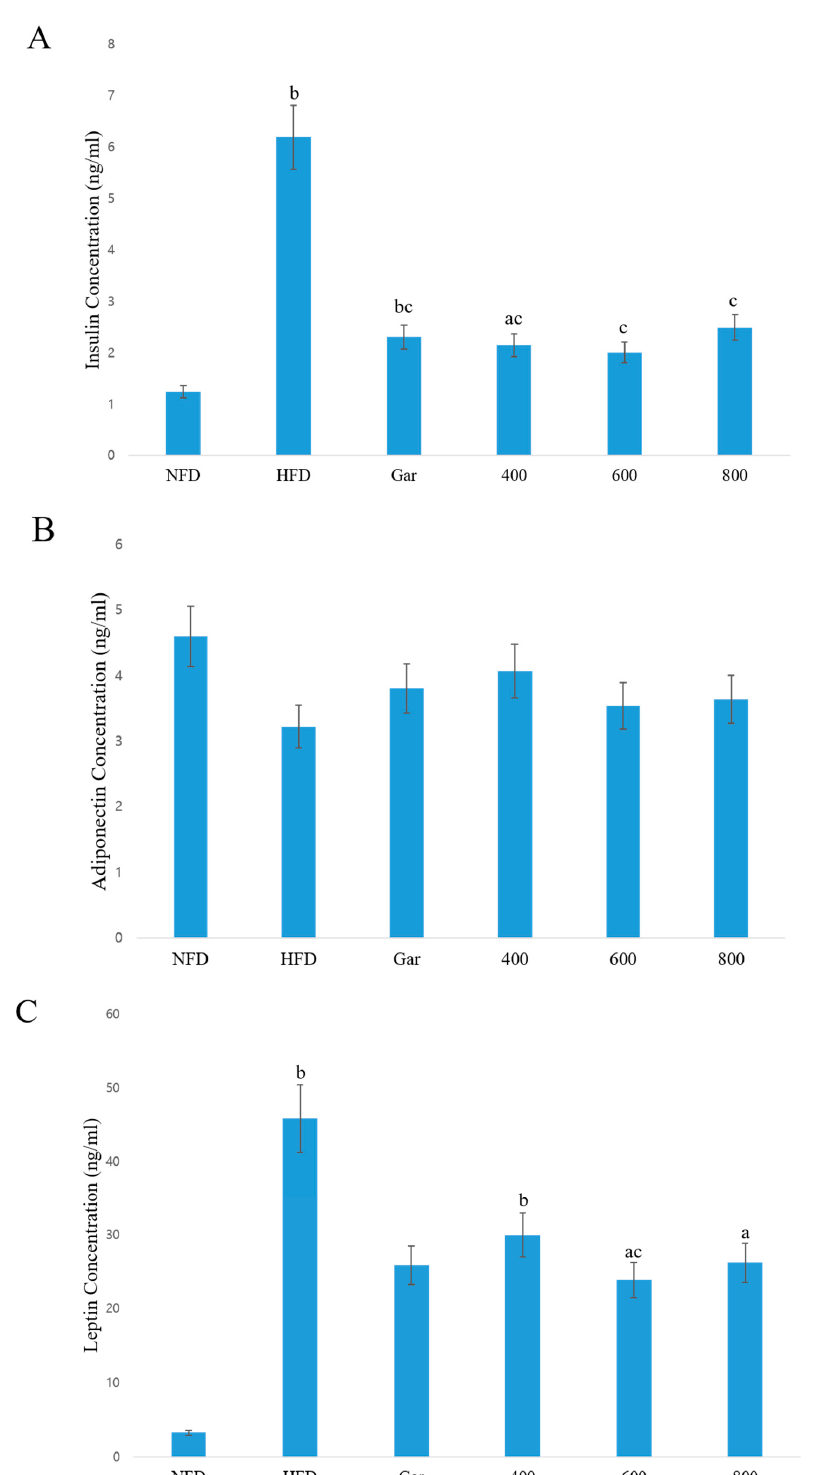
Figure 4. Concentrations of ( A ) insulin, ( B ) adiponectin, and ( C ) leptin in serum were measured by an ELISA kit. NFD; Normal-Fat Diet. HFD; High-Fat Diet. Gar; Garcinia 245 mg / kg / day. 400; The ethanol extract of Cheongchunchal (CE) 400 mg / kg / day. 600; CE 600 mg / kg / day. 800; CE 800 mg / kg / day. The statistical analysis was carried out by the use of a t -test. a p < 0.05 and b p < 0.01 compared with the NFD group. c p < 0.05 compared with the HFD